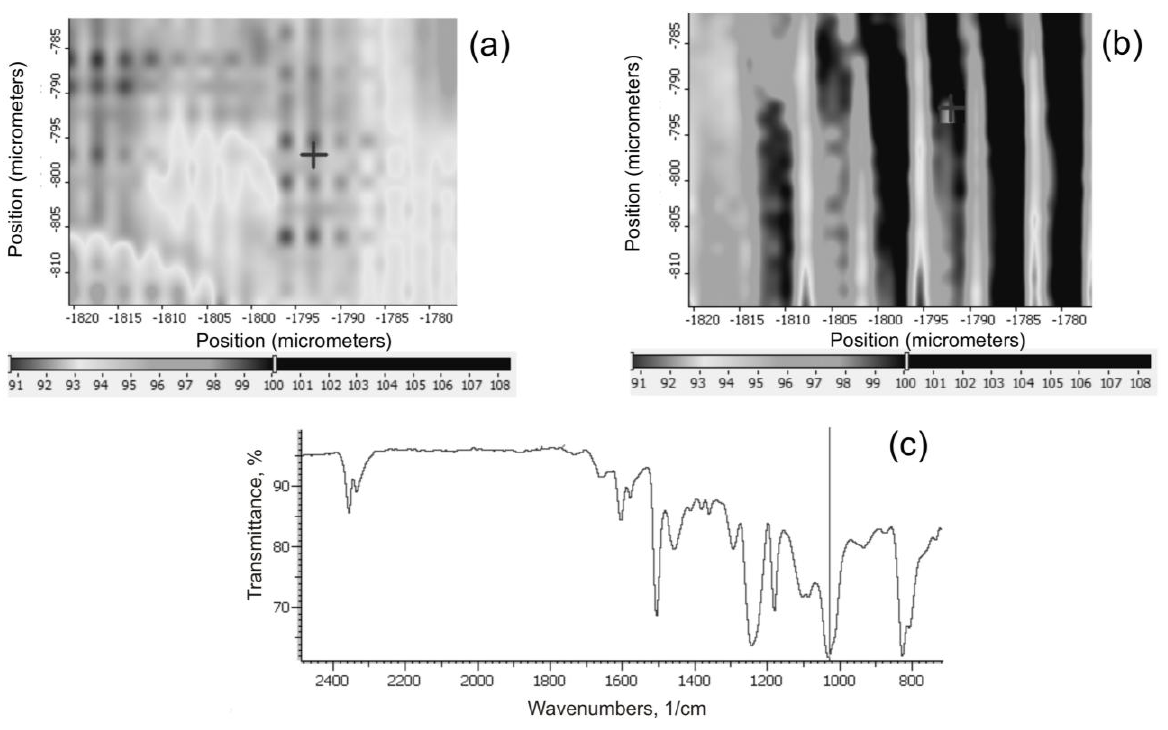
Figure 16. IR maps showing the position of the 1040 cm −1 band characteristic of Si–O–Si groups, in the composites: ( a ) EPBP1IHSP3-3.0; ( b ) EPIHSP3-3.0; ( c ) composite spectrum with marked Si-O-Si band. +, sample surface place on which spectrum ( c ) was